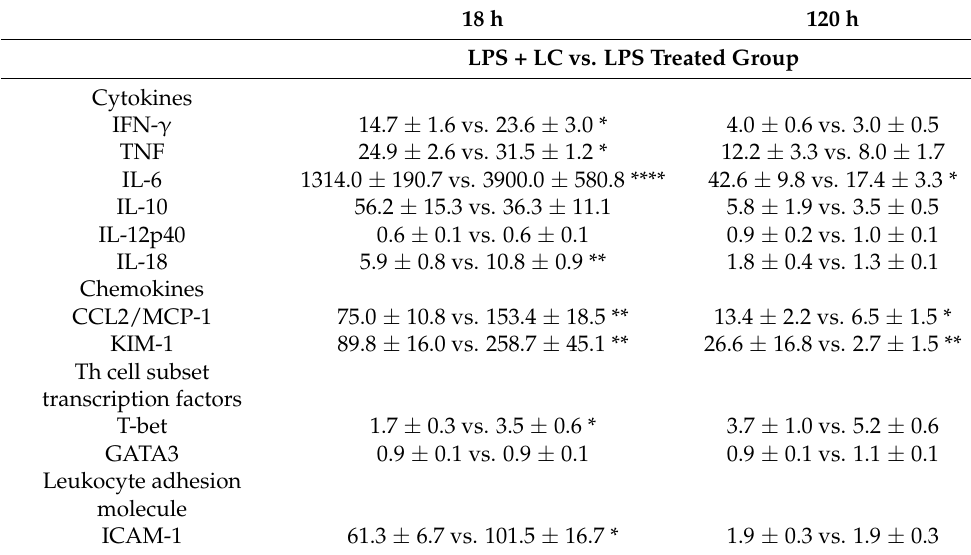
Table 3. Renal mRNA expression of cytokines, chemokines, KIM-1, Th cell subset transcription factors, and leukocyte adhesion molecules by real-time